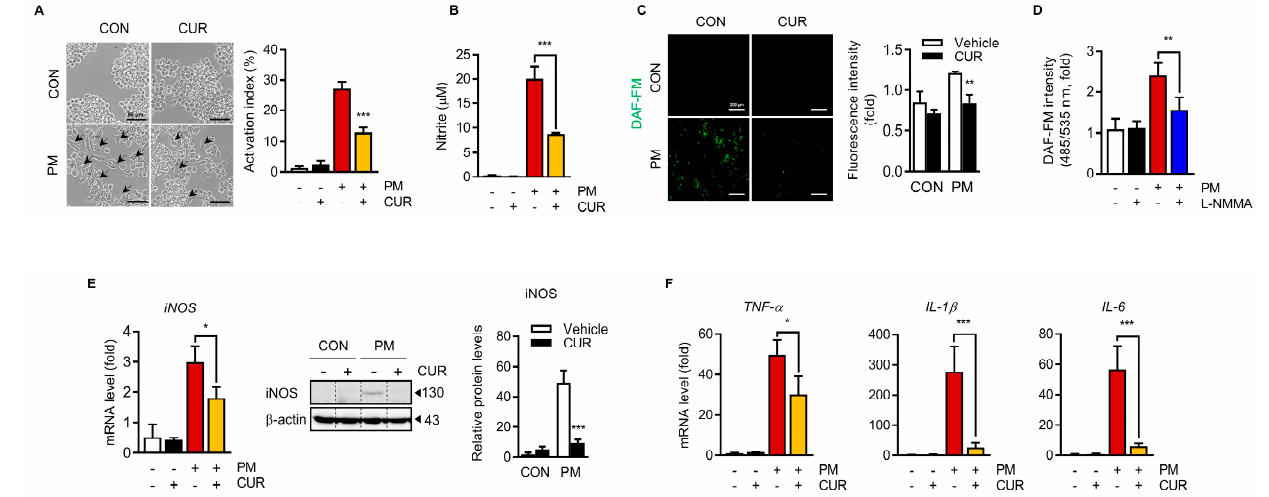
Figure 3. Curcumin attenuated PM-induced nitrite production and inflammatory cytokine expression in RAW264.7 macrophage cells. Effect of curcumin on ( A ) the dendritic transformation of PM- stimulated RAW264.7 cells. Cells were pre-incubated with 10 µ M of curcumin for 1 h, and then treated with 20 µ g/cm 2 of PM for 24 h. Cell morphology was monitored under light microscope at × 200 magnitude. Activated RAW264.7 cells are indicated by arrows. Scale bars indicate 50 µ m. The activation index percentage was expressed as the number of cells with activated morphology relative to the total number of cells, quantified as 7 random fields with total cells above 300. ( B ) Nitrite levels of RAW264.7 macrophage cells against PM-stimulated condition. RAW264.7 were pretreated with curcumin for 1 h, and incubated with PM for 12 h. Nitrite content in the cell supernatants was measured using Griess reaction assay. ( C ) Intracellular oxidative nitrosylation was monitored with fluorescence probe DAF-FM and relative intensity of fluorescence was indicated. Scale bars indicate 200 µ m. ( D ) After treatment with L-NMMA, a NOS inhibitor, the levels of oxidative nitrosylation were measured by DAF-FM probe. ( E ) Expression of iNOS mRNA and protein. ( F ) Expression of proinflammatory cytokines (TNF- α , IL-1 β , and IL-6) by RT-qPCR. Data presented as the mean ± SD of three independent experiments. *** p < 0.005, ** p < 0.01, * p < 0.05 vs. PM 10 -treated group. CON, control group; CUR, curcumin; PM, particulate matter.